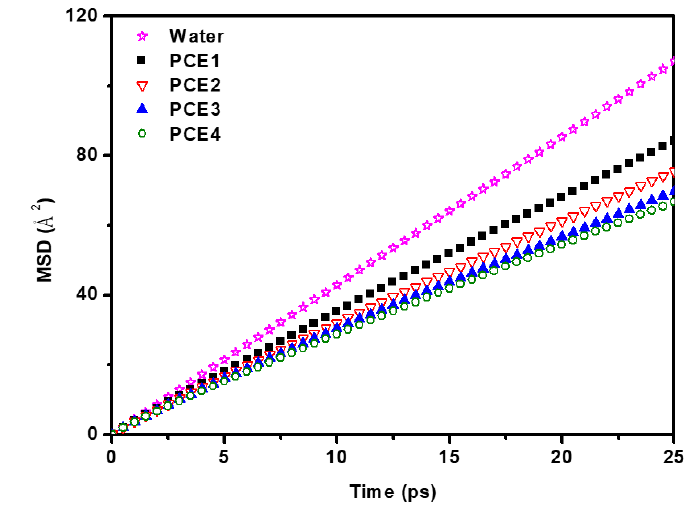
Figure 5. The mean square displacements (MSDs) of water molecules in different systems.